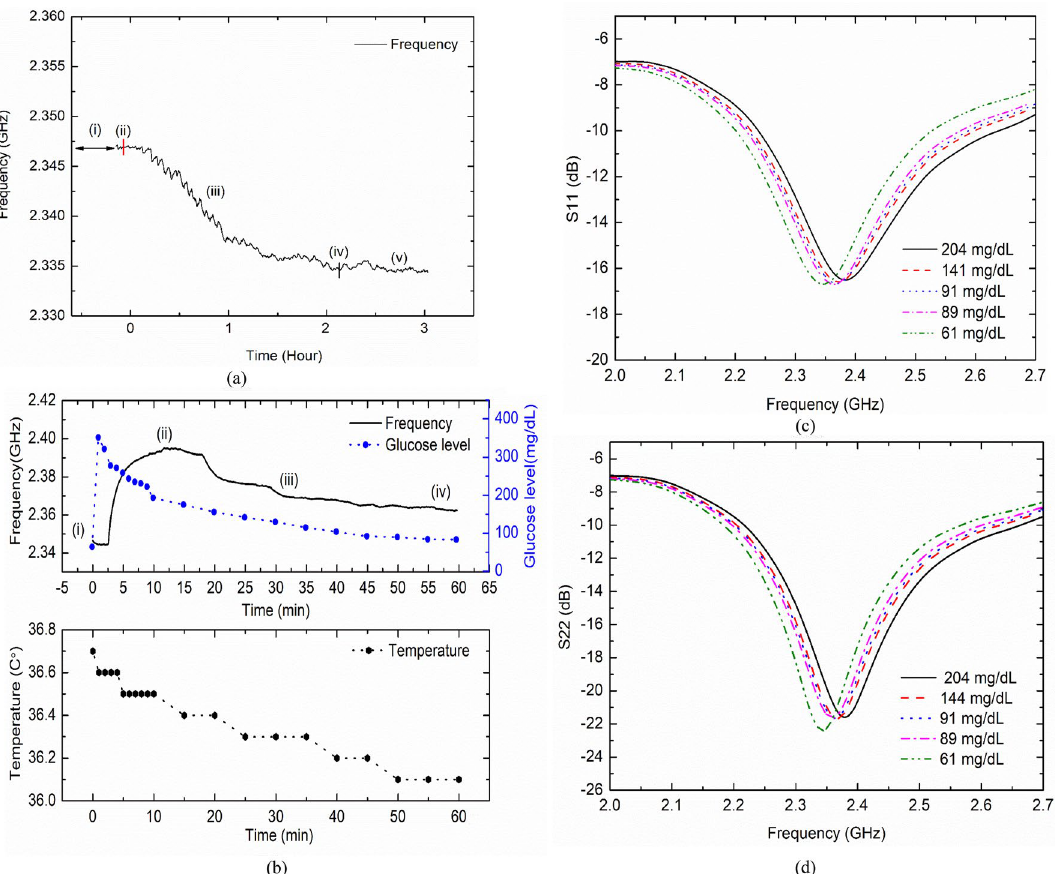
Figure 2. Results of the IVGTT conducted on swine. ( a) Sensor insertion and initial frequency response filtered (i) surgery and sensor insertion (ii) monitoring (iii) frequency drifting (iv) saline (v) frequency drift saturate. ( b) Sensor frequency response after glucose injection (i) Glucose solution injection, sensor resonance (ii) shifts to the maximum frequency, (iii) slowly decreases and follows the BG level, (iv) returns to the initial BG level, and body temperature variation during test. (c) S 11 parameter and ( d) S 22 parameter with respect to ence resonance frequency compared to swine case. Muscle has a higher dielectric permittivity (ε r ~ 40) whereas subcutaneous fat (ε r ~ 8). As a result, even with the same sensor, the reference resonance frequency moved about 300 MHz to the left in beagle compared to swine. In addition, the temperature effect on the sensor behavior should not be neglected. Since, the dielectric permittivity is also affected by temperature variations. During experiment core body temperature of the animal subject measured using a rectal temperature sensor. Experiments were done inside a temperature-controlled surgery room. During first IVGTT experiment on swine, it was observed the body temperature of the swine dropped after surgery, anesthesia, and glucose injection. However, the sensor frequency was unaffected and fol- lowed the BGL trend. In the second IVGTT experiment on beagle, heating pads were used to keep animal warm and body temperature was maintain during experiment. The total variation in measured body temperature was 0.6 °C and 0.1 °C for swine and beagle respectively during experiment. After inserting the sensor into the beagle, the resonance frequency was measured continuously for approxi- mately 2 h until the resonance frequency was reached at a stable condition without variation. Thereafter, PBS without glucose was administered into the beagle and the sensor frequency was continuously observed (1 h). This was done to mimic the sham test and verify the sensor behavior. Then, the IVGTT was performed, and continu- ous sensor resonance measurement and BG level measurement at regular 5-min time intervals were performed. As BG changed, the sensor frequency also changed. The sensor frequency and trend in beagles varied in a similar way as in the case of swine. As soon as the glucose solution was injected, the BG level rapidly increased compared to the sensor frequency (Fig. 3a upper). The delay between the BG level and sensor frequency was approximately 10 min due to the glucose diffusion process from the blood to the ISF. When the BG level changed from 450 to 129 mg/dL (Δ Gl = 321 mg/dL), the resonant frequency shifted from 2.0836 GHz to 2.0732 GHz (Δ f = 10.34 MHz). As a result, the sensitivity change with respect to BG was approximately 32 kHz per 1 mg/dL of change in BG levels (Δ f /Δ Gl = 10.34/321 MHz/mg/dL). The variations in rectal temperature were recorded using a precision thermistor sensor inserted into the body. The temperature change was 35.4–35.5 °C during the experiment (Fig. 3a lower). With an increase in the BG level, the resonance